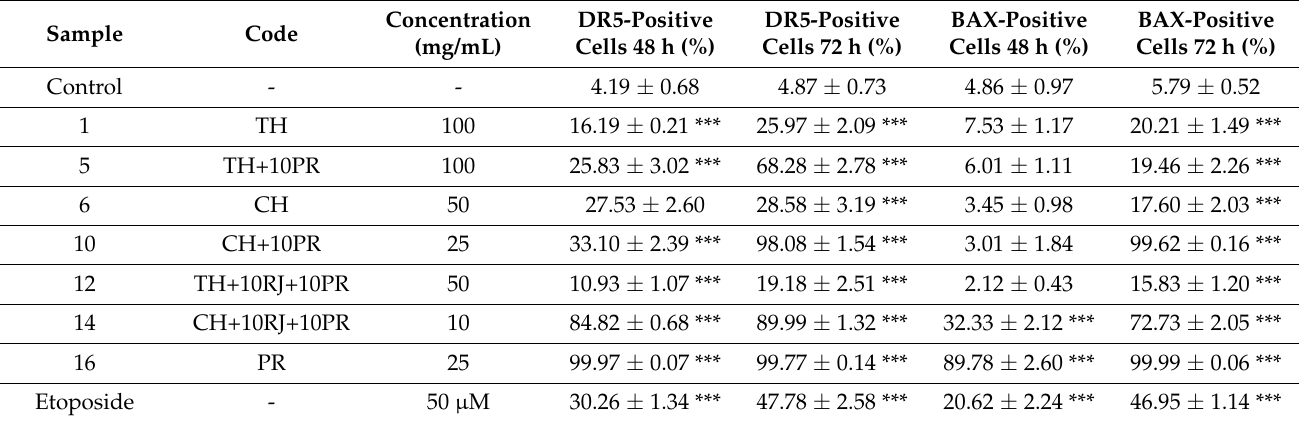
Table 3. Effect of selected samples (1, 5, 6, 10, 12, 14, and 16) and etoposide on DR5 and BAX activation in HepG2 cells, as evaluated using flow cytometry at 48 and 72